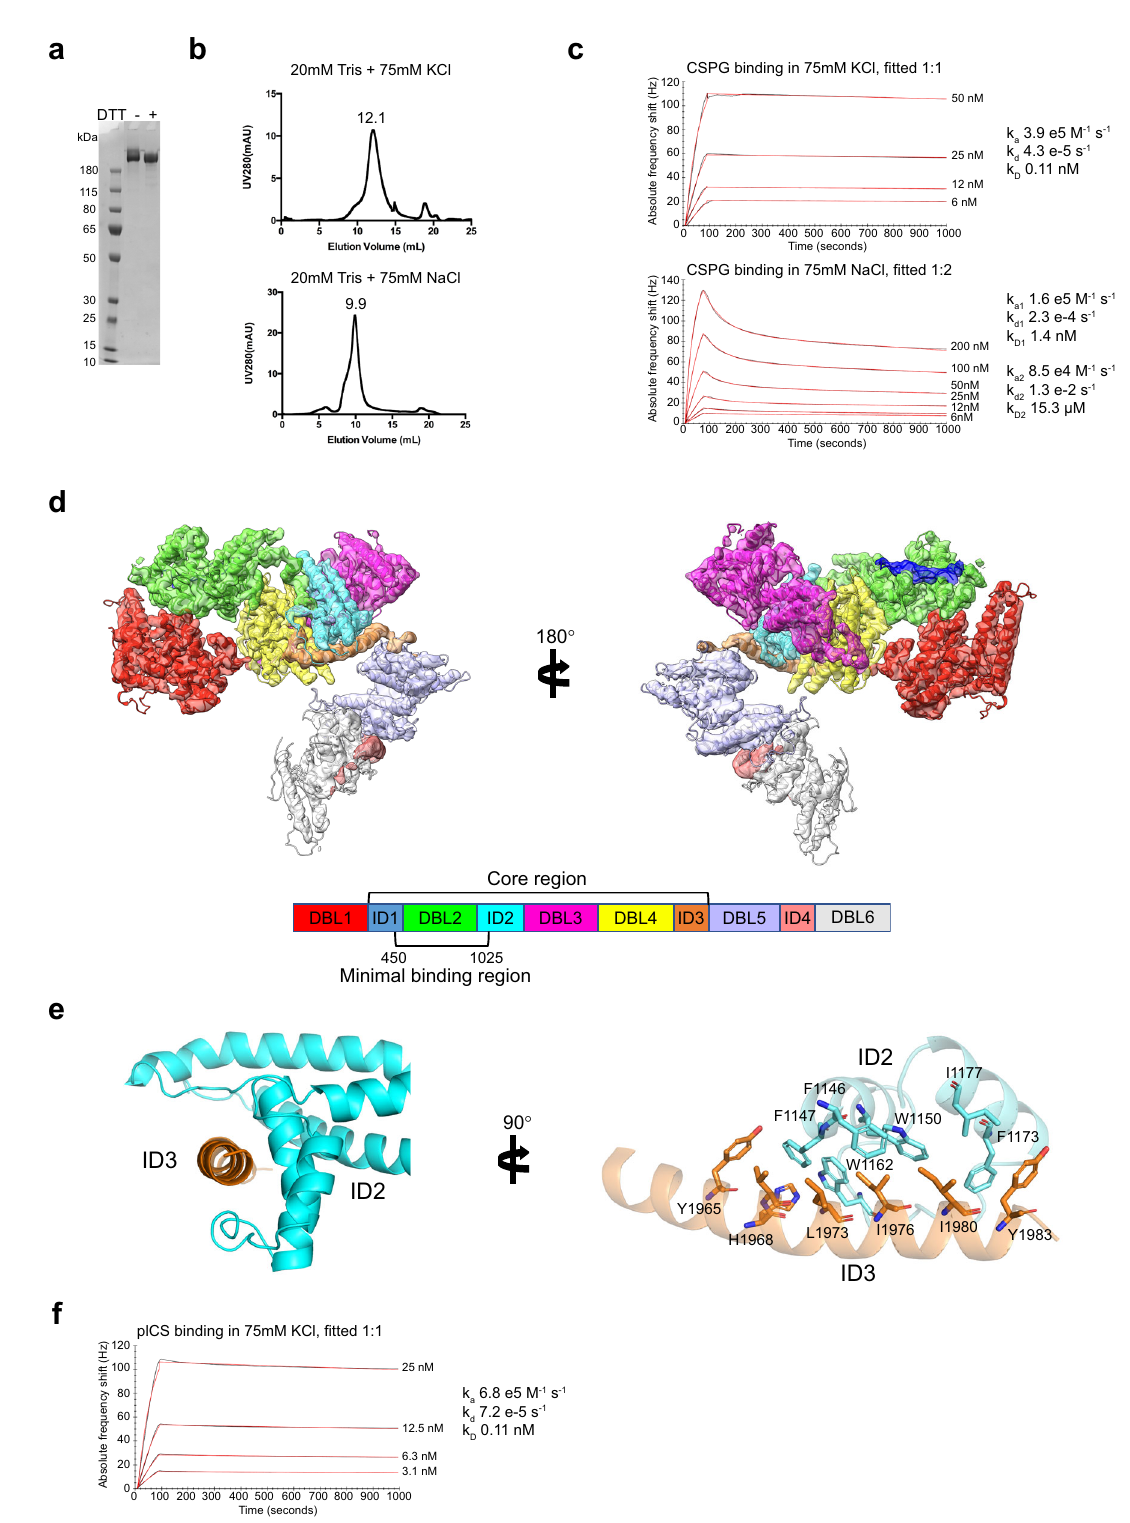
Fig. 1 Apo-structure of the ectodomain of VAR2CSA. a SDS-PAGE non-reduced/reduced of full-length VAR2CSA (307 kDa). A gel was run after puri fi cation of VAR2CSA before the protein was aliquoted and stored at − 80 °C until used. b Gel fi ltration pro fi le of VAR2CSA in different buffers, top panel KCl, bottom panel NaCl. c QCM biosensor interaction between CSPG decorin and VAR2CSA, top panel KCl (k D 0.11 nM), bottom panel NaCl (k D1 1.4 nM). Black curves represent recorded data, red curves fi tted data. d Overall structure of VAR2CSA, fl ipped 180° to the right. The separate domains are colored as shown in the overview below. The core region of the structure and minimal CS binding region (AA450-1025) are indicated in the legend. e α - helix from ID3 (orange) AA1955-1985 interaction with C-terminal part of ID2 (blue). To the right the structure is fl ipped 90° and side chains from interacting residues are shown as sticks and labeled. For clarity, helices are shown with 50% transparency. f QCM biosensor interaction between plCS and VAR2CSA in buffer with KCl (k D 0.11 nM). Black curves represent recorded data, red curves fi tted data. Source data are provided in source data fi